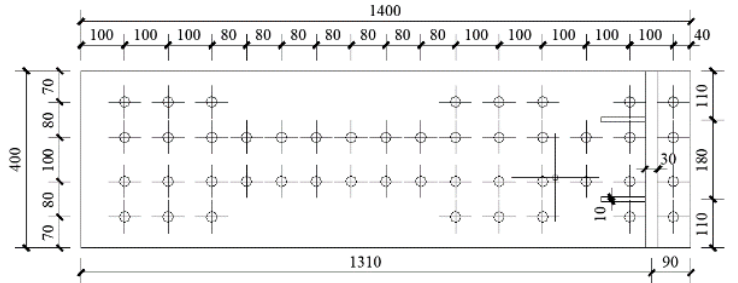
Figure 2. Detailed drawing of 60 mm thick large bottom plate (units: mm).